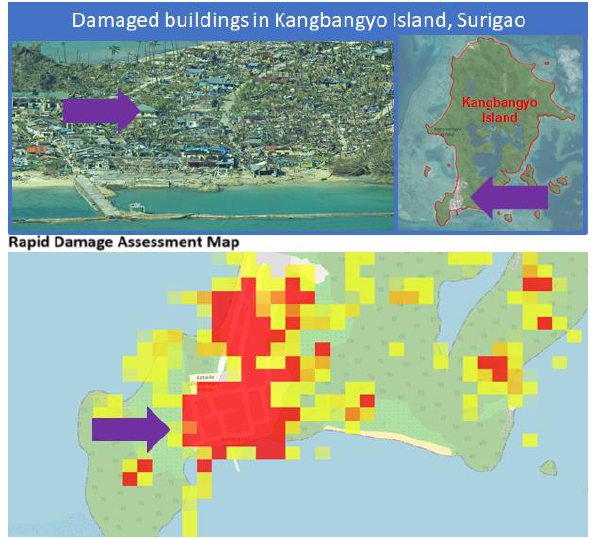
Figure 9. Comparison of the SAR-derived rapid damage assessment map and an aerial photo from PCG. Good correspondence is shown in the images. Photo © PCG, 2022. Basemap © OSM